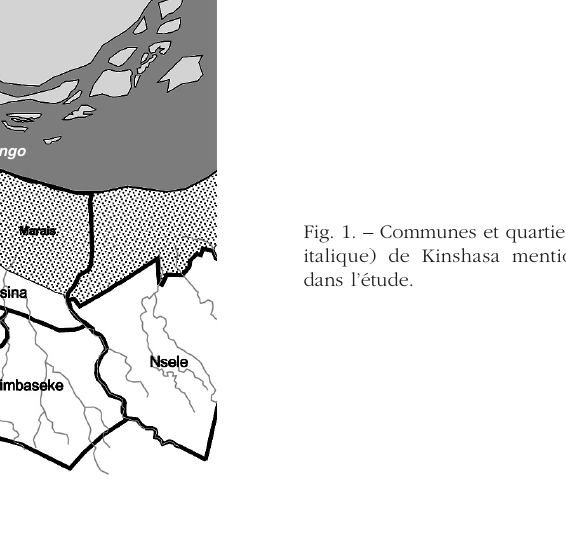
Fig. 1. – Communes et quartiers (en italique) de Kinshasa mentionnés dans